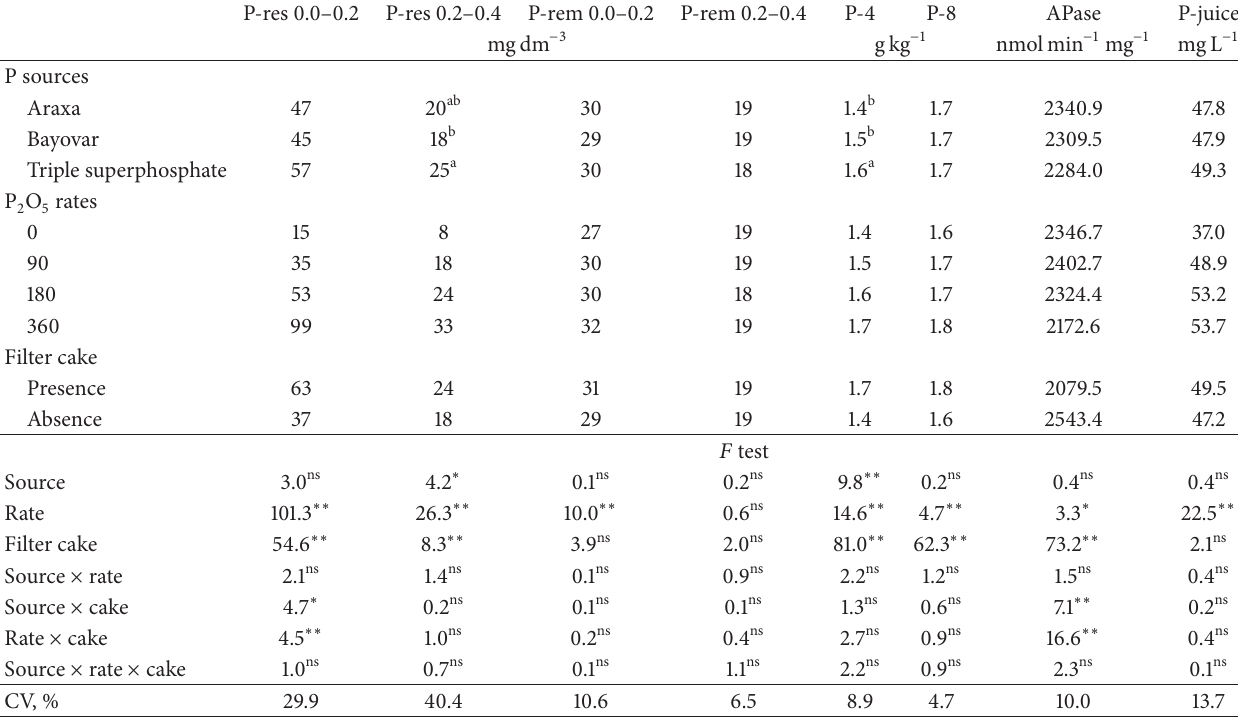
Table 1: Soil phosphorus determined by the resin method (P-res) and by the remainder method (P-rem) at depths of 0.0–0.2 m and 0.2–0.4 m, leaf phosphorus at four months (P-4) and at eight months (P-8) after sprouting, and acid phosphatase activity (APase) and juice phosphorus (P-juice) of sugarcane grown in Eutrophic Red Ultisol, as a function of phosphate fertilization with source, application rate, and filter